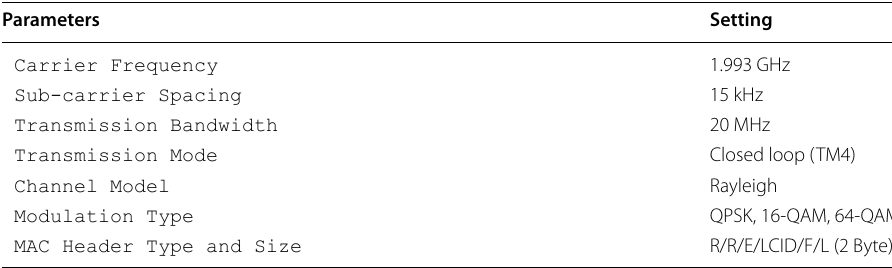
Table 3 Parameters setting of LTE simulation Parameters